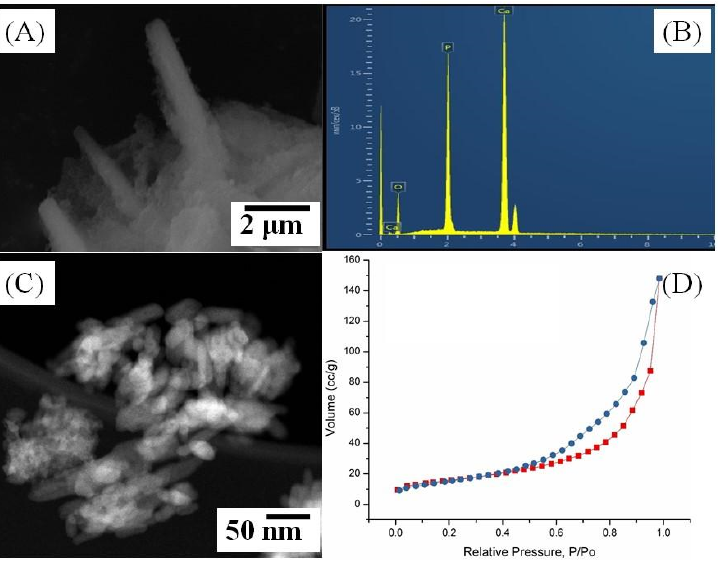
Figure 3. SEM micrograph ( A ), EDX spectrum ( B ), HAADF-STEM ( C ) image and nitrogen adsorption–desorption isotherm of commercially purchased HAp ( D ).